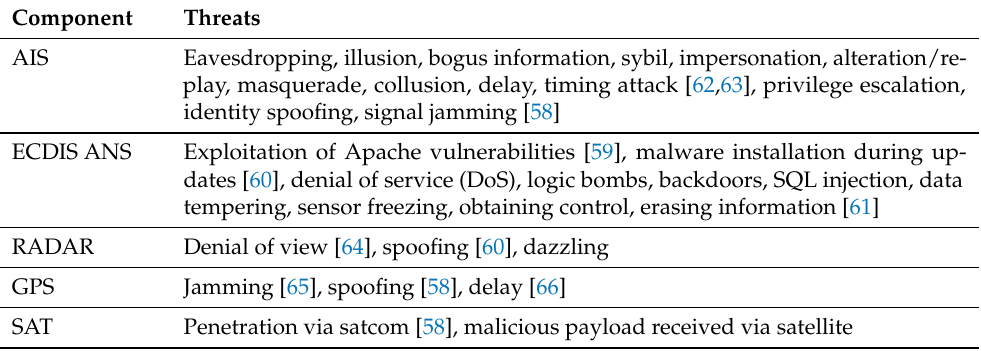
Table 2. Example of Threats for the Autonomous